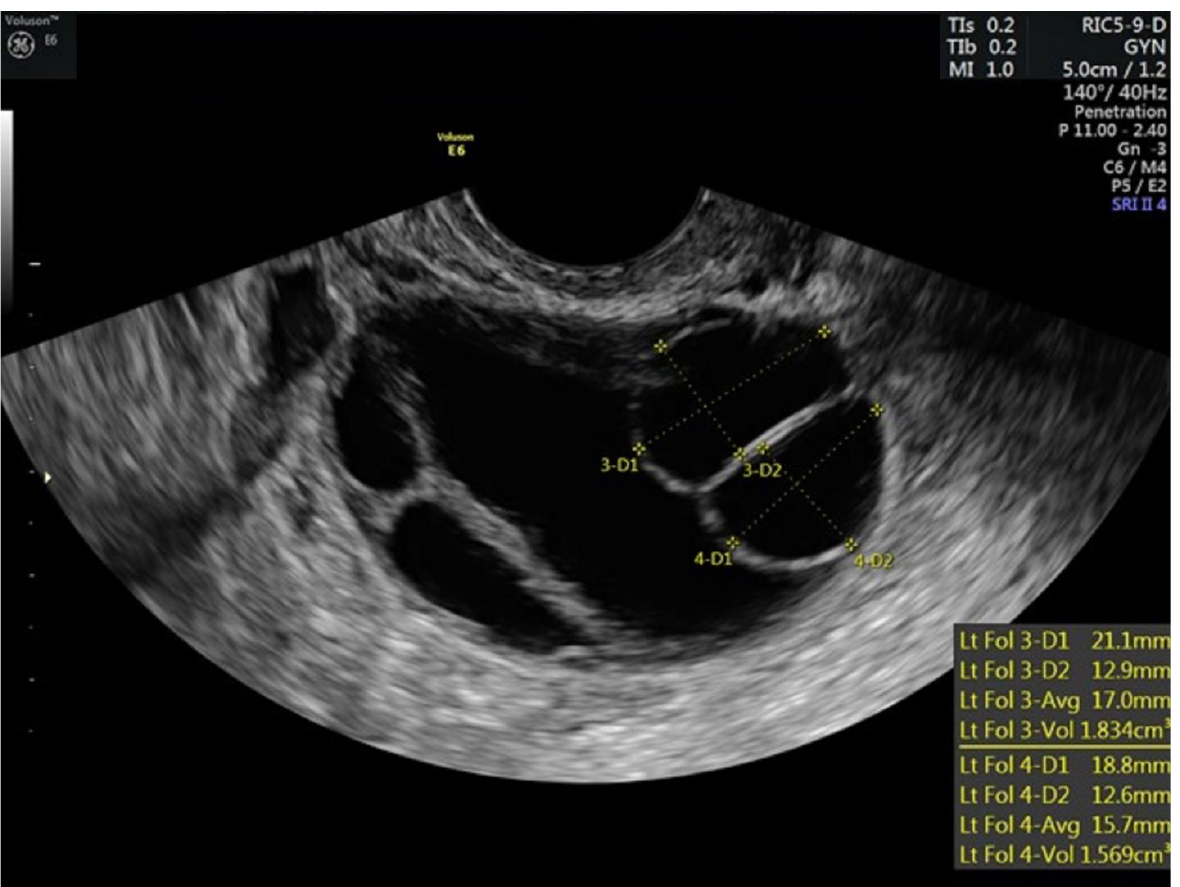
Figure 2. Stimulated left ovary of patient prior to trigger injections.